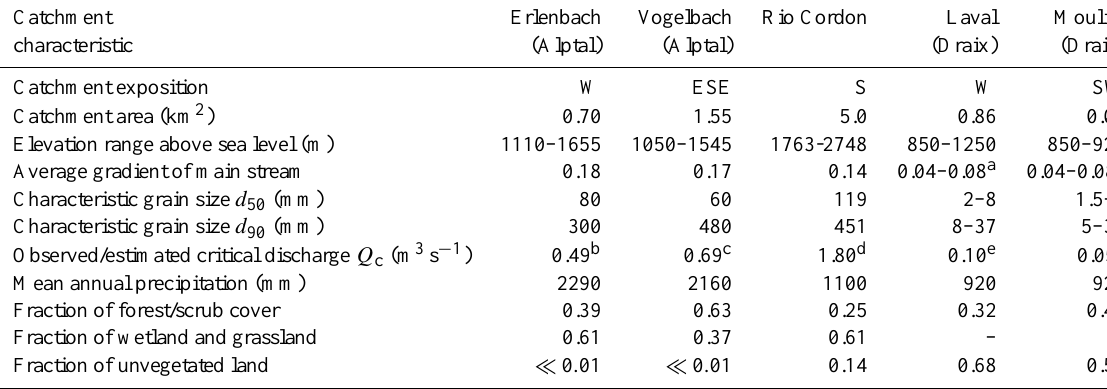
Fraction of wetland and grassland Fraction of unvegetated land (cid:28) 0 .